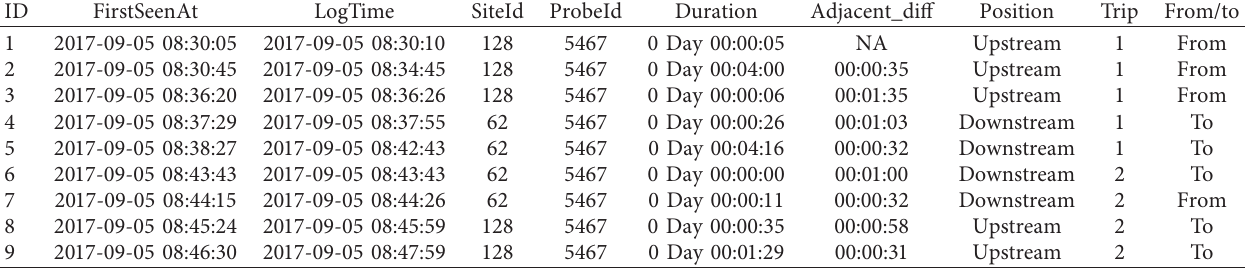
Table 2: An example of multiple records of a MAC address at a